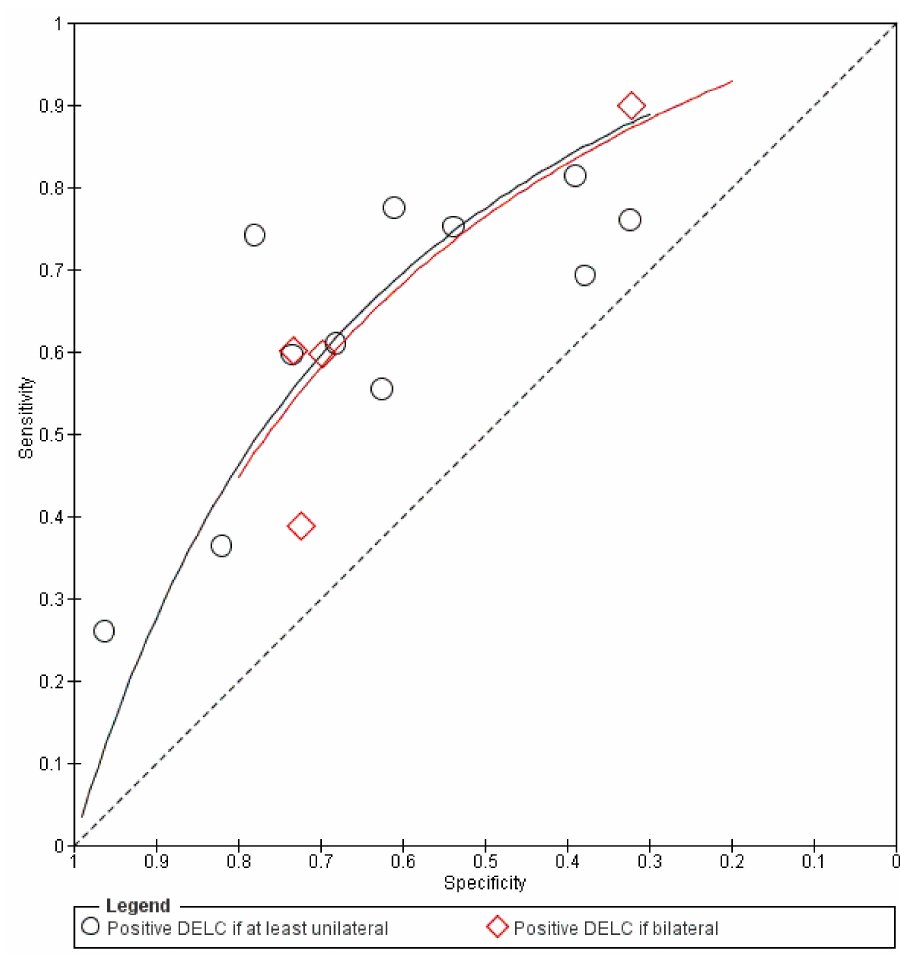
Figure 6. Summary receiver operating characteristic plot.